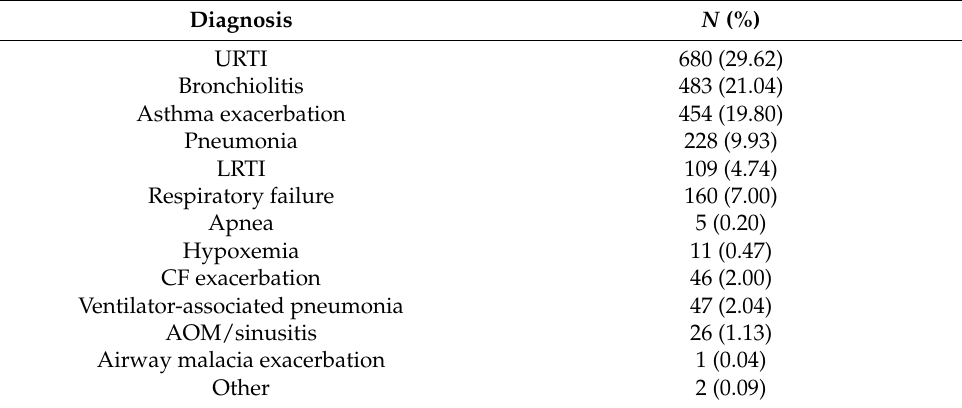
Table 1. Respiratory diagnosis in patients with compatible symptoms ( n = 2295).